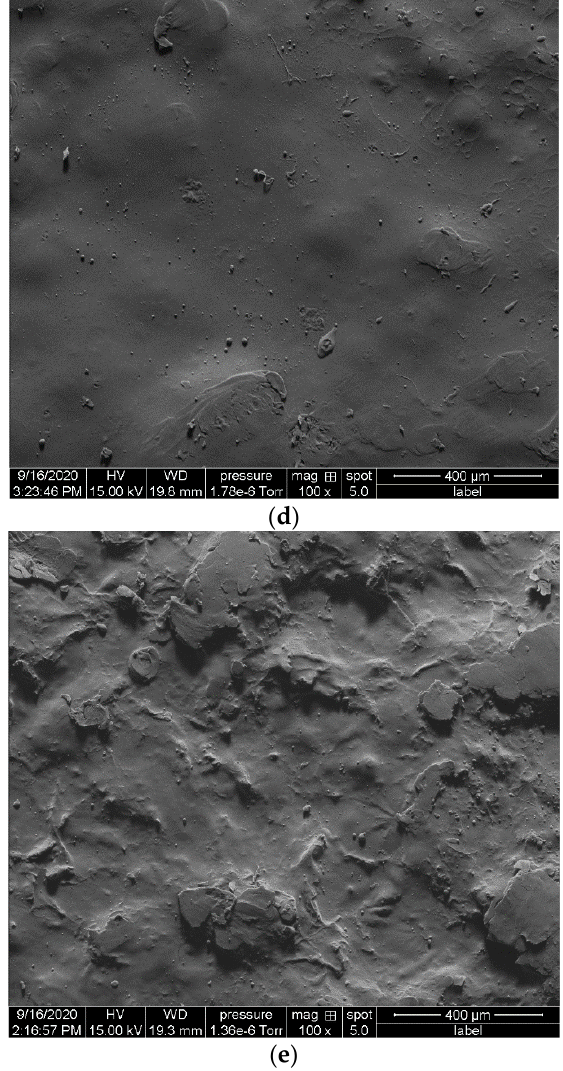
Figure 5. Micrograph of prepared films ( a ) PLA; ( b ) PLA-UCF10; ( c ) PLA-UCF20; ( d ) PLA-TCF10 and; ( e ) PLA-TCF20.